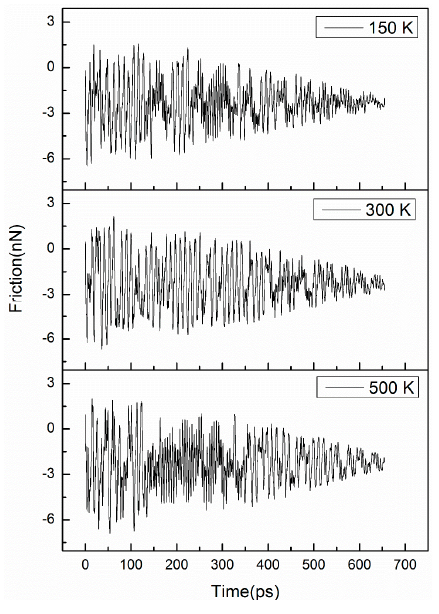
Figure 6. Variation of friction force between shells with time for temperatures of 150, 300, and 500 K.